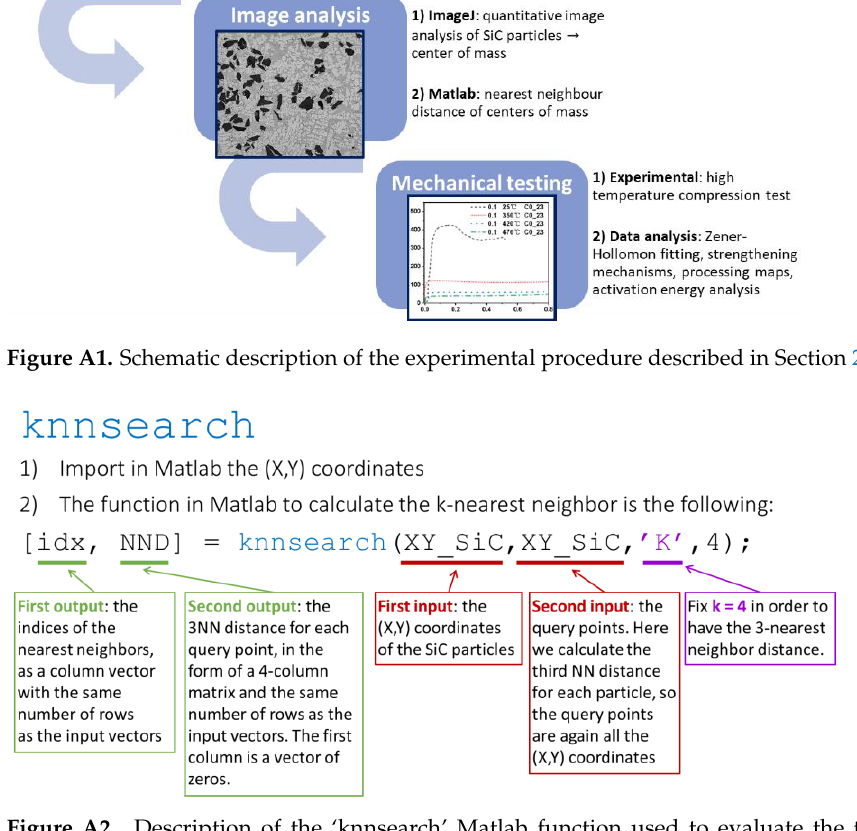
Table A1. The comparison between experimental data and calculated values with Δσ LB and Δσ MM.